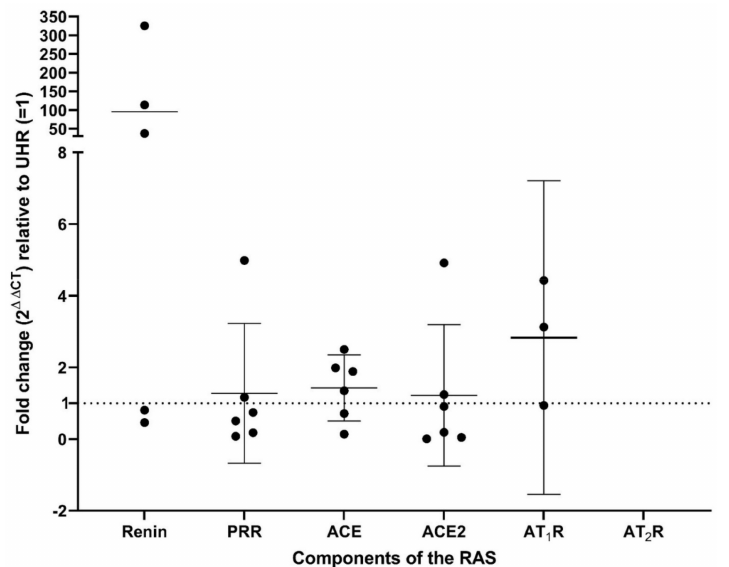
Figure 4. Fold-change (2 ∆∆ CT ) in gene expression of the components of the renin-angiotensin system (RAS): renin, PRR, ACE, ACE2, AT 1 R, and AT 2 R, determined by RT-qPCR on total RNA extracted from six renal clear cell carcinoma tissue samples. CT values were normalized to the reference genes GAPDH and PUM1 and displayed as expression relative to universal human reference RNA (UHR). Error bars represent 95% confidence intervals of the mean.